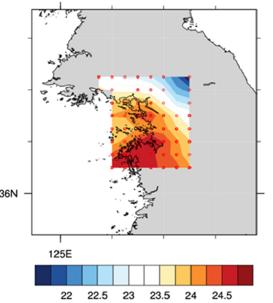
Figure A1. WBGT* in Seoul, South Korea at 12:00 local time on 1 July 2017.